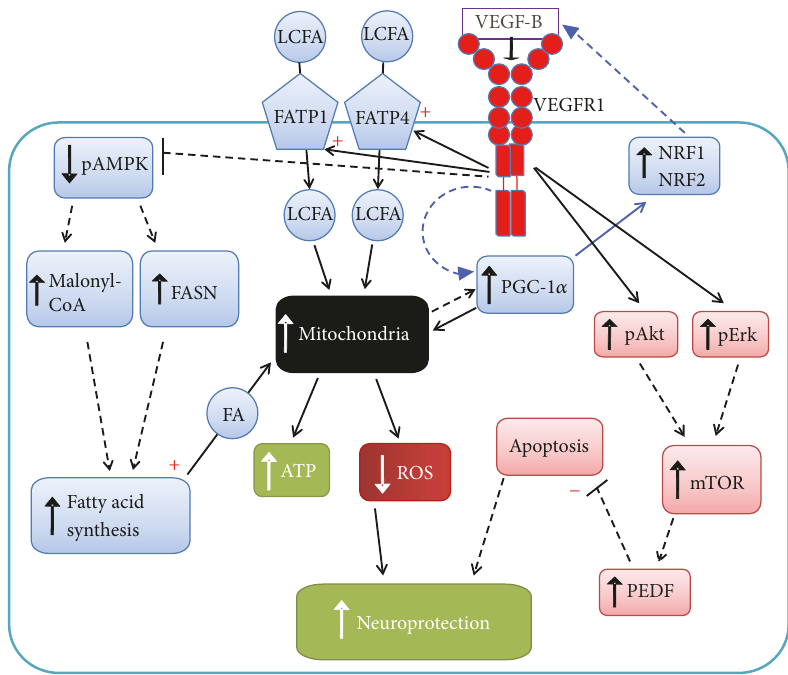
Figure1:ProposedmechanismsofVEGF-B’sprotectiveeffectsindopaminergicneurons.Blacksolidlinesindicatepathwayspreviouslyshown for DA cells. Black dashed lines indicate hypothesized pathways, based on other cell types. Blue lines indicate a possible feedback loop between VEGF-B and PGC-1 𝛼 . Arrowheads and + signs: activation, − signs: inhibition. LCFA: long chain fatty acids; FA: fatty acids. In neuron survival, VEGF-B via VEGFR-1 upregulates pAkt and to a lesser extent pErk. Given data seen in cardiac tissue and sensory neurons, we propose that